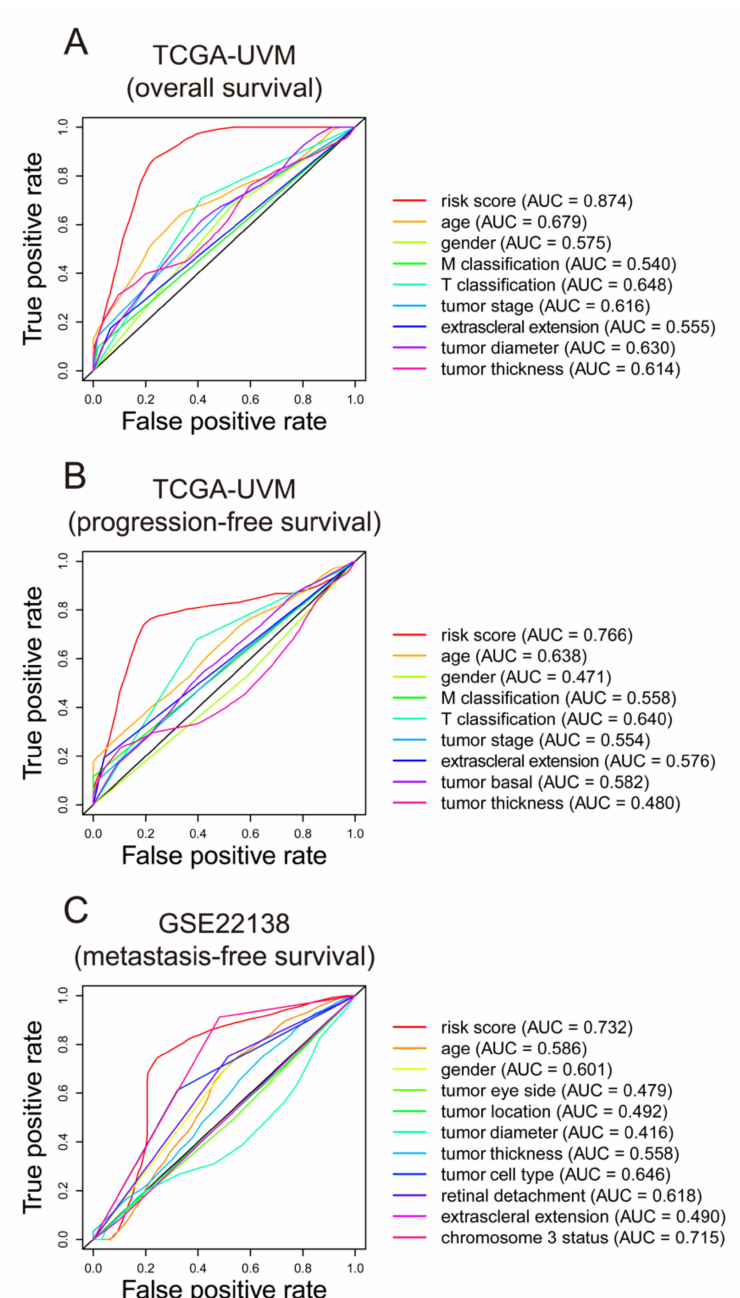
Figure 5. ROC curves of the seven-gene signature. The ROC curves were constructed by risk score, age, gender, T classification, M classification, tumor stage, etc. to show the prognostic ability of each variable. The ROC analyses were conducted in TCGA-UVM cohort based on overall survival and progression-free survival ( A , B ), and in GSE22138 cohort based on metastasis-free survival ( C ). ROC: Receiver operating characteristic; AUC: area under the ROC curve. TCGA: The Cancer Genome Atlas; TCGA-UVM: A project ID in The Cancer Genome Atlas